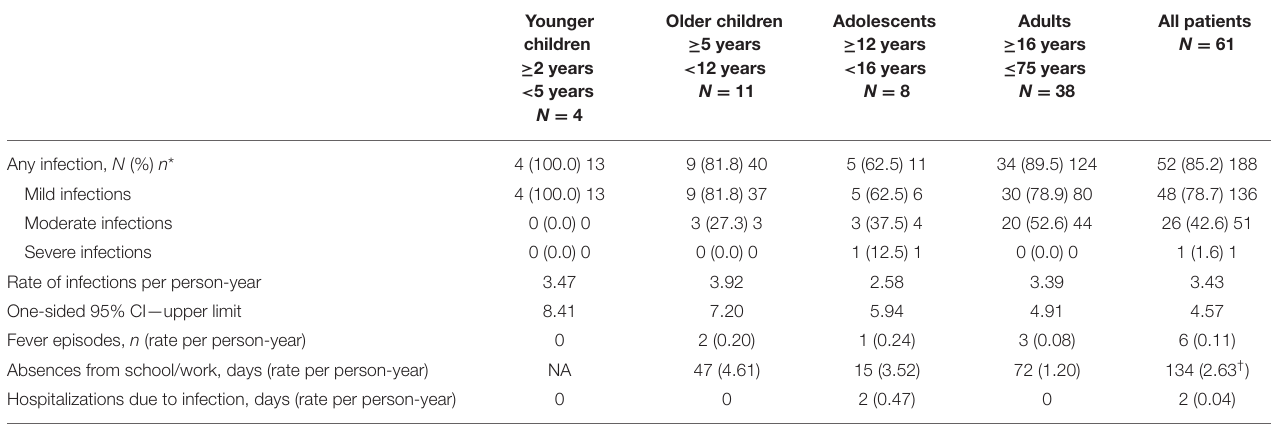
TABLE 3 | Efficacy parameters during treatment with octanorm.